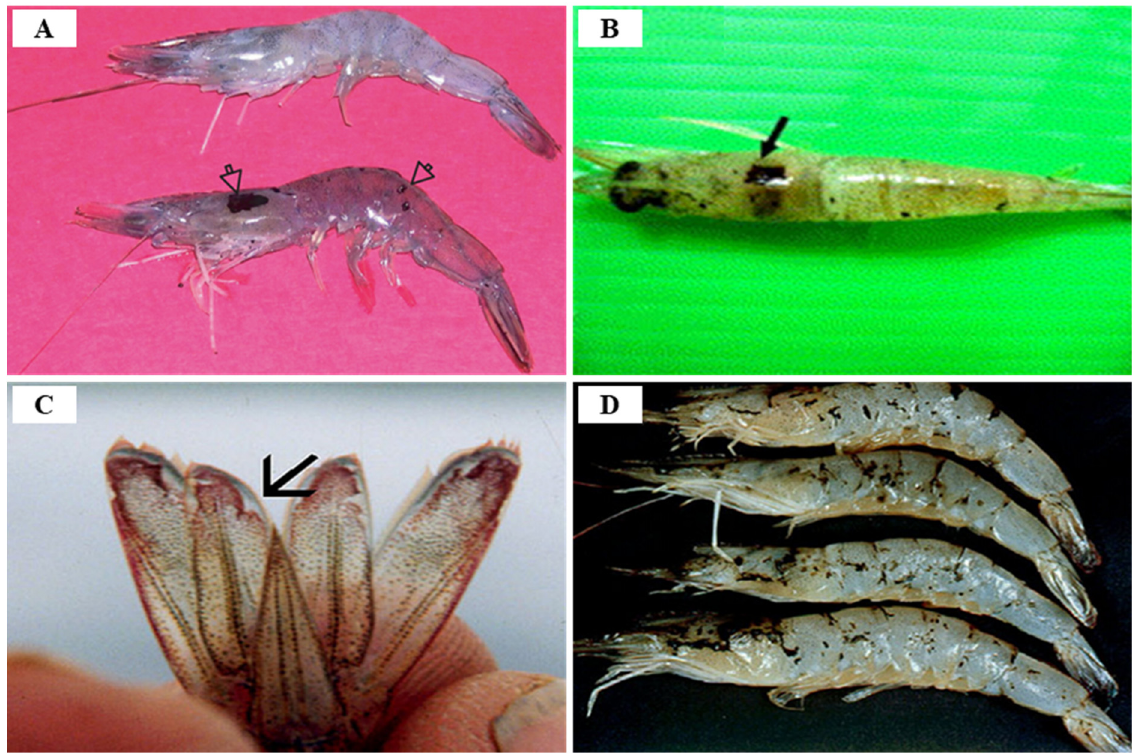
Figure 19. External symptoms of Taura syndrome virus (TSV) on infected shrimp. ( A , B ) Penaeus vannamei showing typical signs of TSV at the end of the acute phase: Multifocal and melanized lesions on the thorax and tail (indicated by arrow); ( C , D ) P. vannamei showing signs of TSV: red tail fan with rough edges on the cuticular epithelium of uropods (indicated by arrow) and multiple melanized cuticular lesions. (( A ) Reprinted from Elsevier Books, Dhar, A.K., Allnutt, F.T., Taura Syndrome Virus. In Encyclopedia of virology, p. 8, Copyright (2008), with permission from Elsevier; ( B ) Reprinted from Aquaculture, Vol. 260 (1 – 4), Phalitakul, S., Wongtawatchai, J., Sarikaputi, M., Viseshakul, N., The molecular detection of Taura syndrome virus emerging with White spot syndrome virus in penaeid shrimps of Thailand, p. 9, Copyright (2006), with permission from